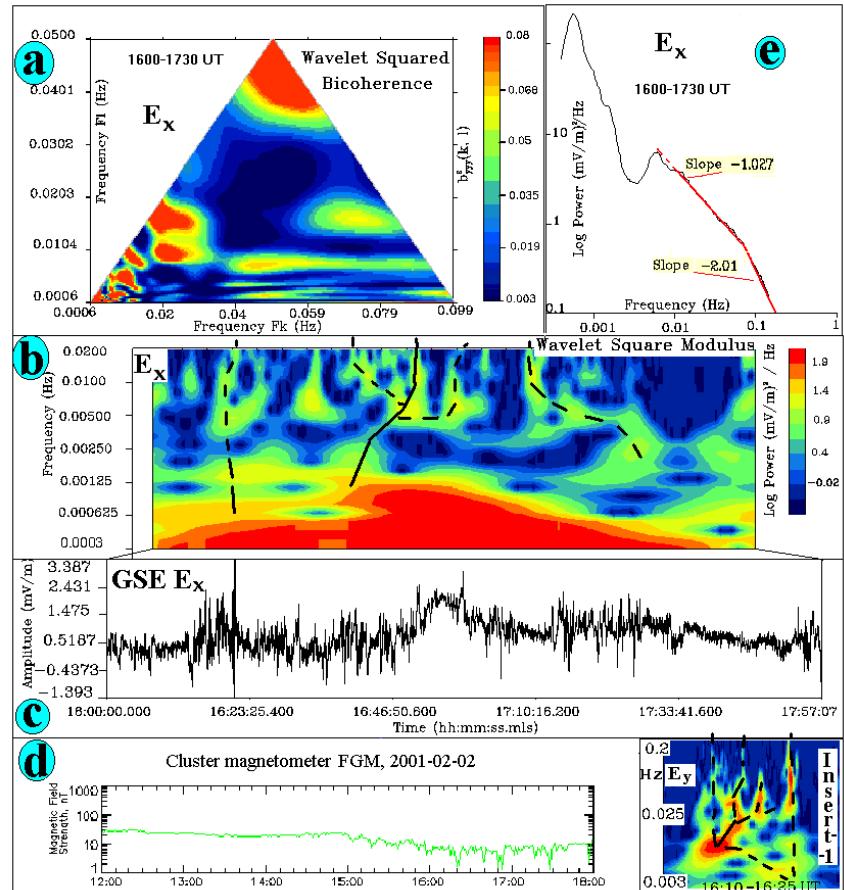
Fig. 17. An outbound turbulent boundary layer crossing by Cluster on 2 February 2001. Panels (a) and (e) show E X bi-spectrogram and integrated spectrum at 16:00–17:30 UT, respectively. Panel (b) displays a wavelet E X spectrogram in the range of 3–20 mHz, inferred cascades are depicted by black lines. Panel (c) demonstrates the electric field E X waveform and panel (d) the magnetic field. Note, in particular, that the magnetic field drops to very low values in a few cases. Insert 1 in panel (d) shows the most characteristic example of the cascade-like E Y wavelet spectrogram at 16:10–16:25 UT (see text for details).